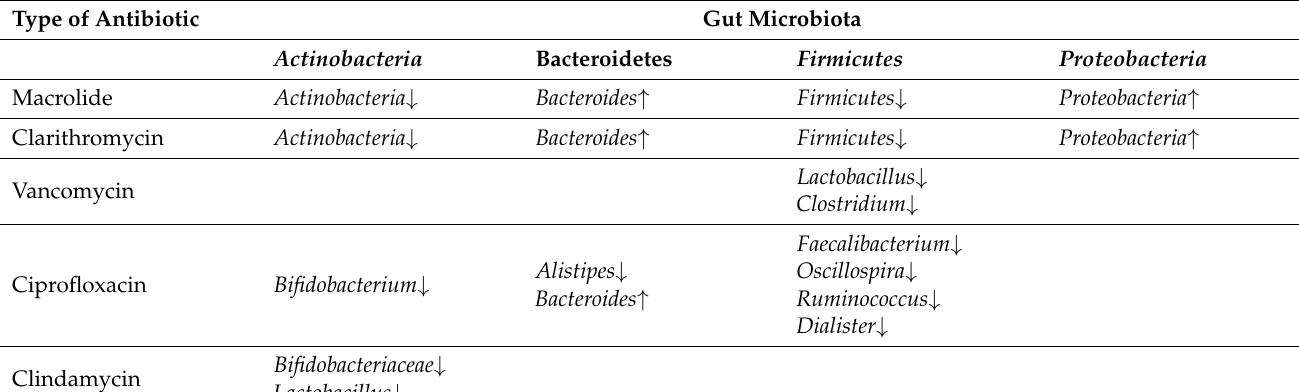
Table 1. Changes in the intestinal microbiota depending on the type of antibiotics taken [7,35]. ↑ means increase in the number of bacteria, ↓ decrease in the number of